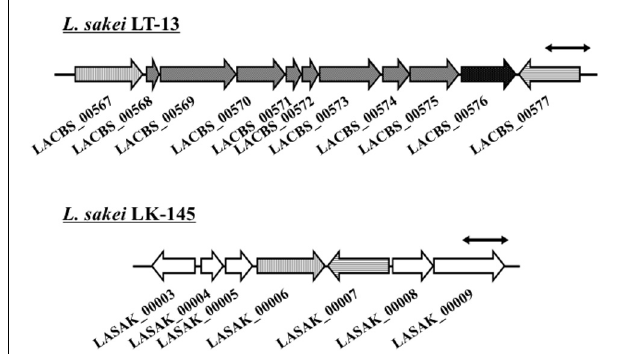
FIGURE 1 | Genome map near malY gene of Lactobacillus sakei LT-13. A portion of L. sakei LT-13 genome near malY gene was compared to counter-region of L. sakei LK-145 genome. Solid bar with double arrowheads indicates 1 kb length. LACBS_00567: drug:H(+) antiporter; LACBS_00568: